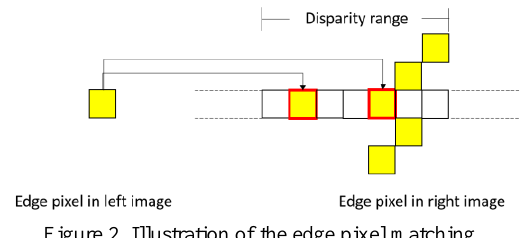
Figure 2. Illustration of the edge pixel